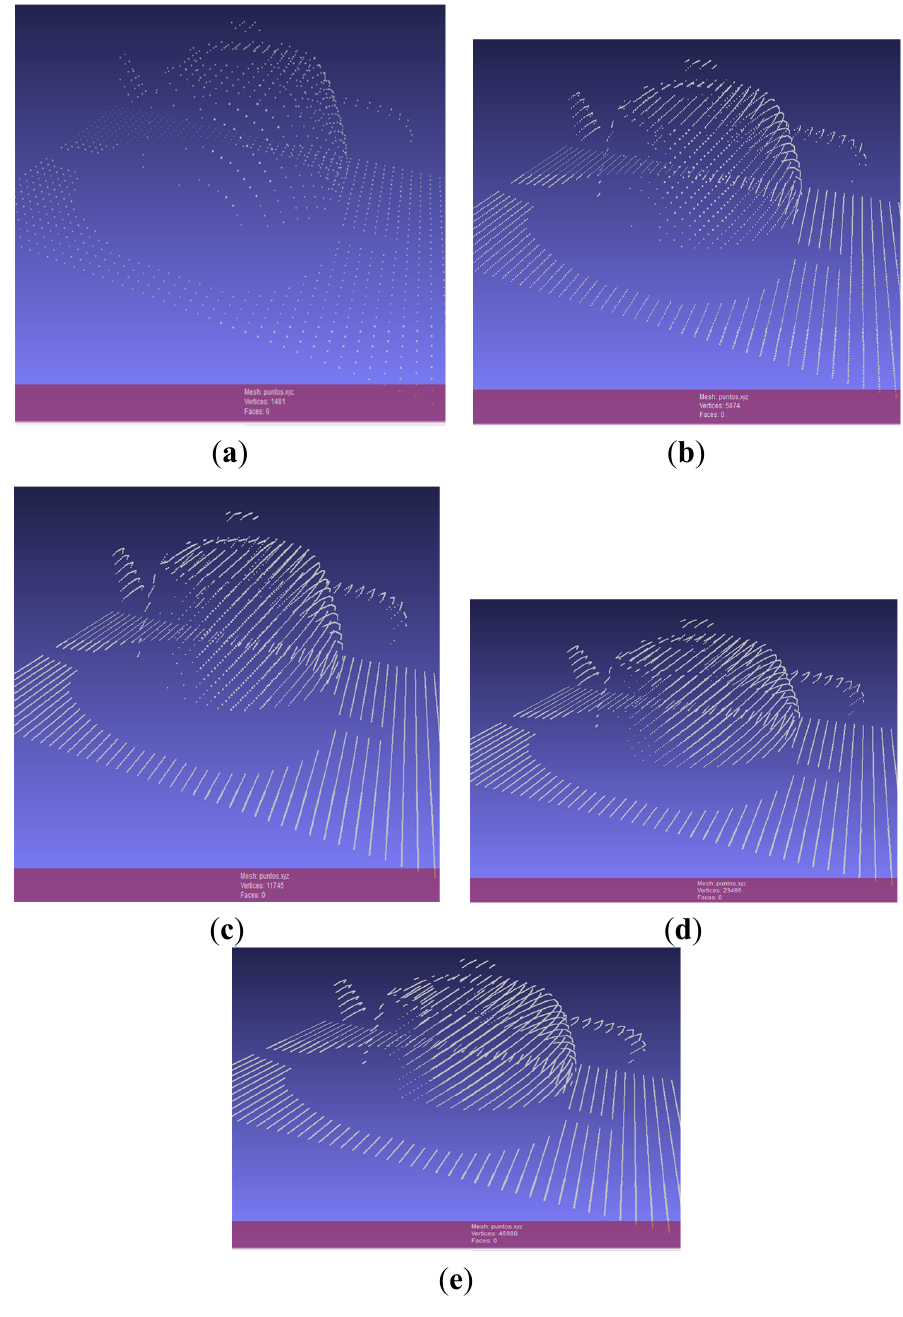
Figure 7. Expansion of the simulated PSD array size: ( a ) 32 PSD; ( b ) 128 PSD; ( c ) 256 PSD; ( d ) 512 PSD; and ( e ) 1024 PSD.